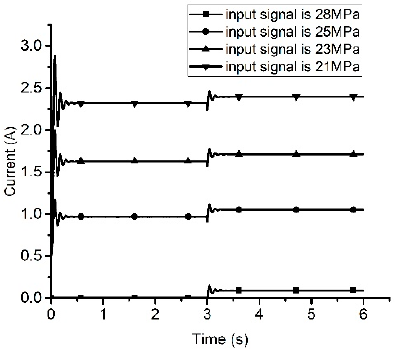
Figure 9. Current Response of EHPAAPP with the LQR method in the case of a different input signal with flow disturbance at the third second.